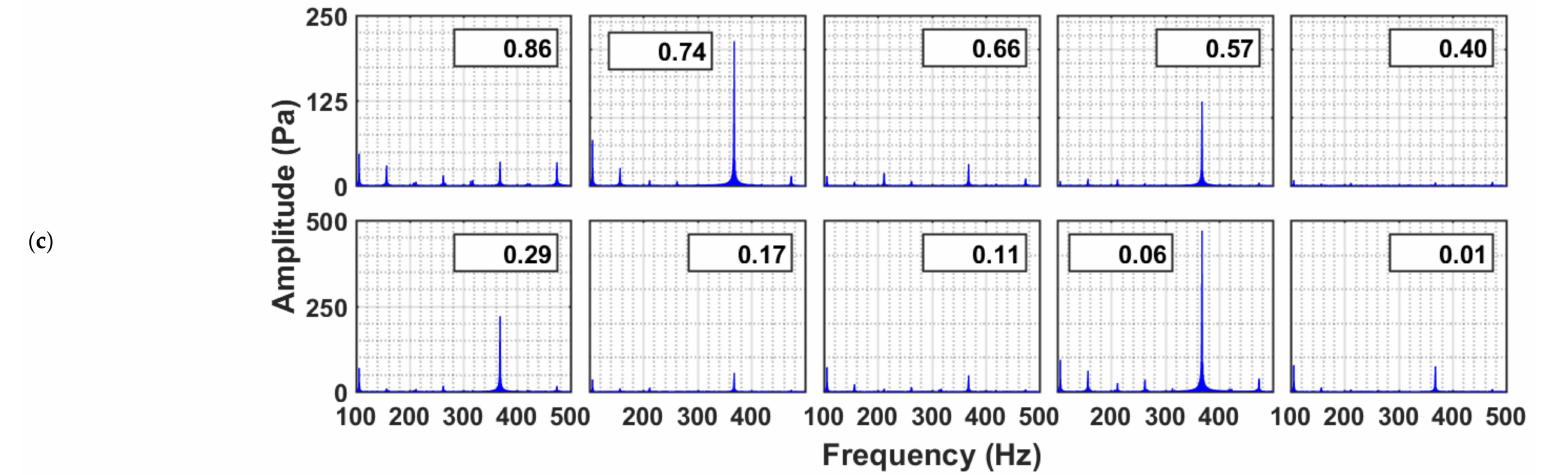
Figure 5. Frequency spectra of the local pressure transients in a closed empty column subjected to sound waves of frequencies ( a ) 220, ( b ) 240, and ( c ) 360